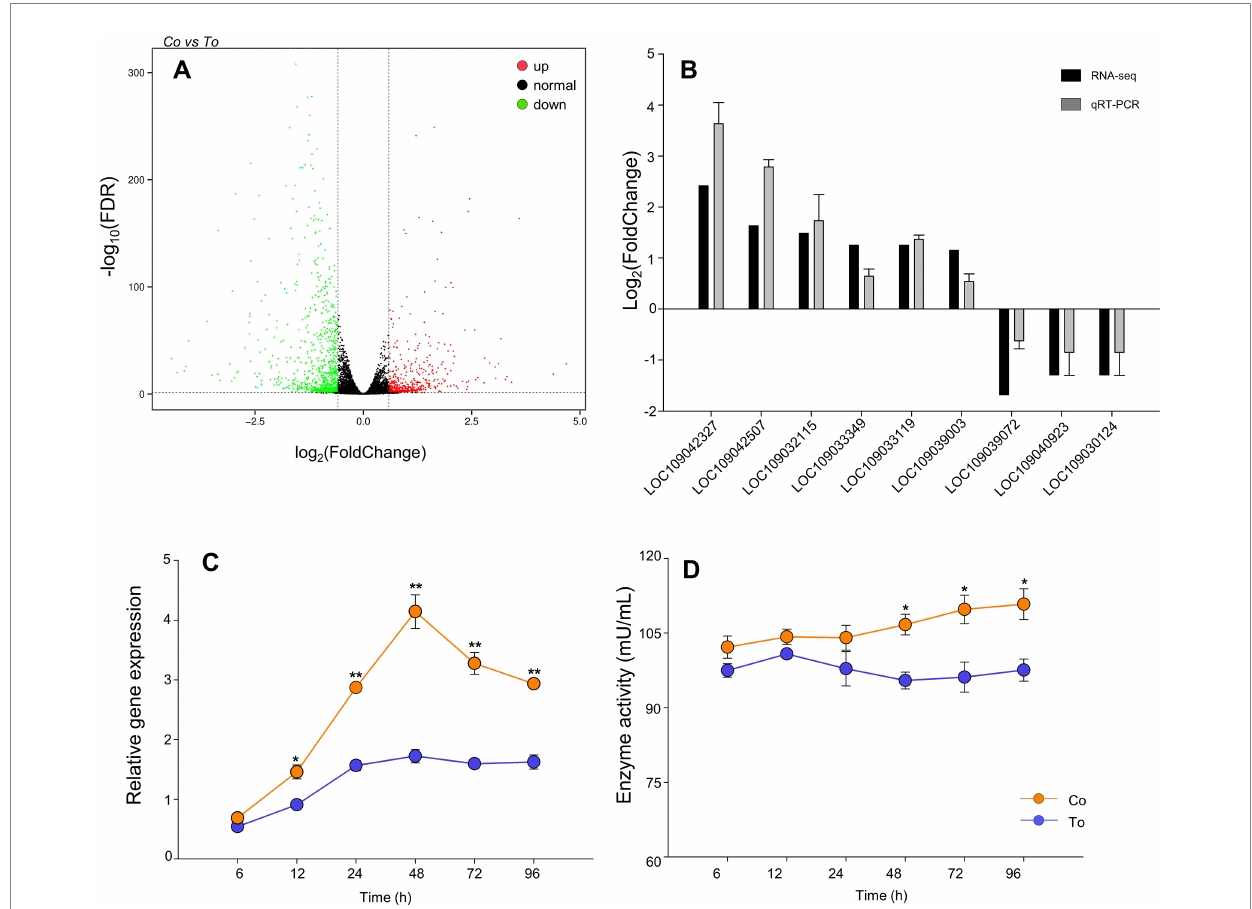
FIGURE 3 Differentially expressed genes. (A) Volcano plot of differentially expressed genes. Red dot shows significantly upregulated genes, green dot shows significantly downregulated genes, black dot represents genes that no significant expression changes, the horizontal axis shows the fold change of gene expression in different samples, and the vertical axis shows the significance of gene expression changes. (B) RT-qPCR validation of selected differentially expressed genes. (C) The relative gene expression of cathepsin B in B. tabaci MED that fed on ToCV and TYLCV co-infected and ToCV- infected tomato plants under various AAP. (D) The enzyme activities of cathepsin B in B. tabaci MED under various AAP. Data are denoted as mean ± SE. *** indicates a significant difference at p < 0.001; ** indicates a significant difference at p < 0.01; * indicates a significant difference at p <